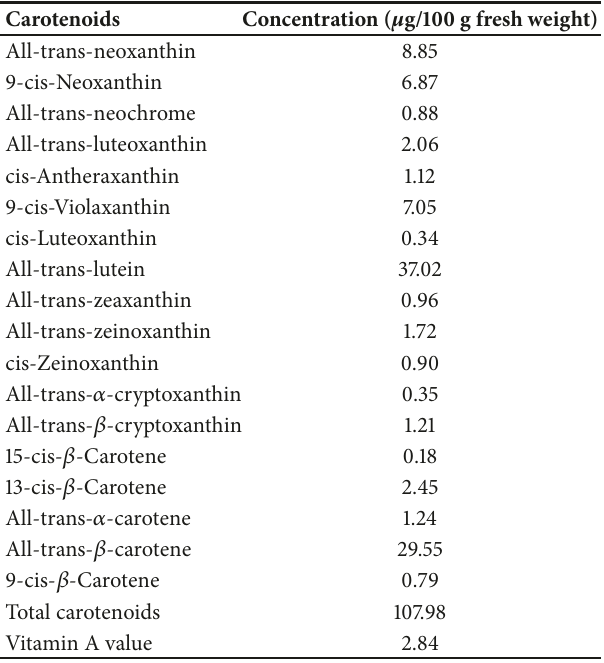
Table 4: Concentration ( 𝜇 g/100 g fresh weight) of carotenoids of jackfruit and their vitamin A values ( 𝜇 g RAE/100 g fresh